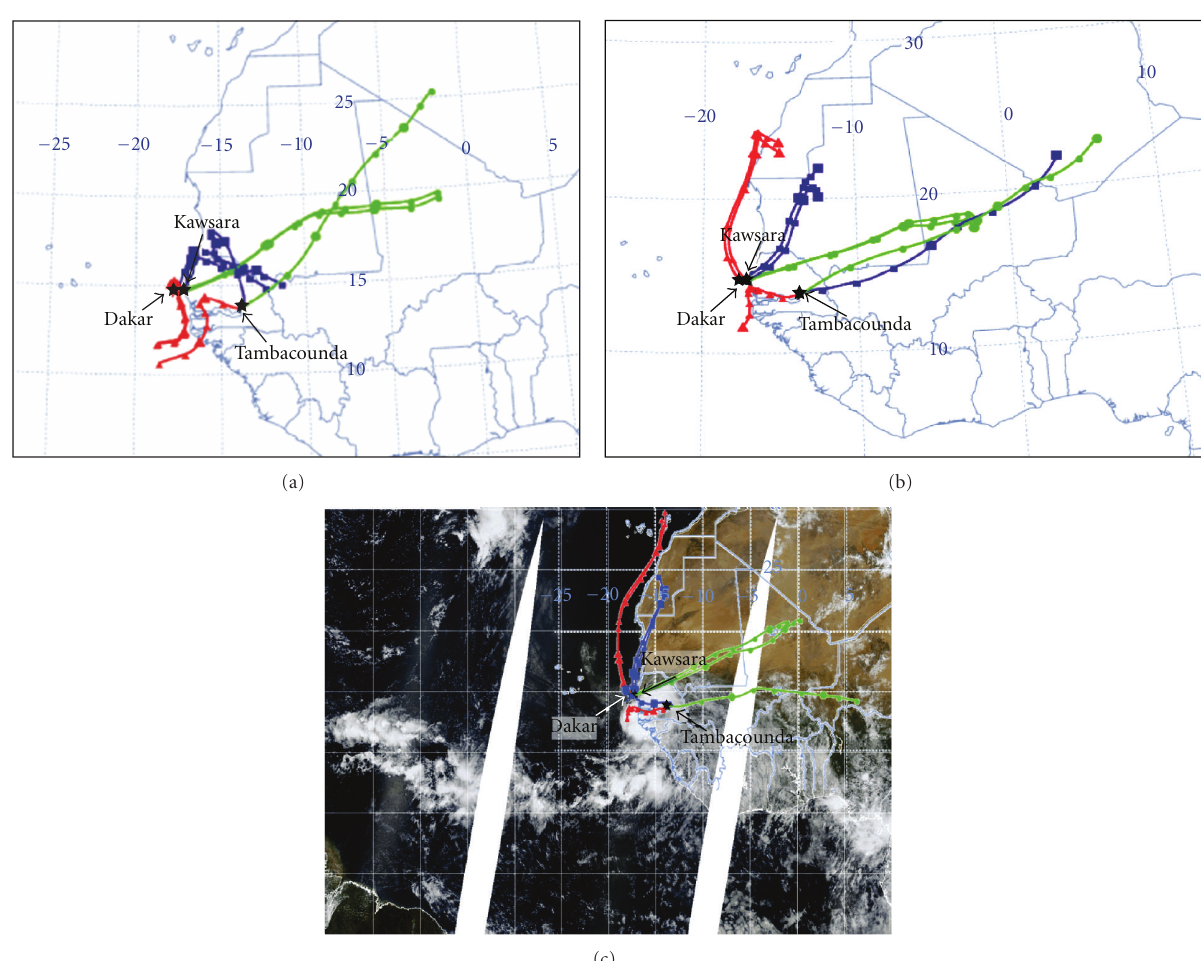
Figure 14: (a) The 48-hour HYSPLIT back-trajectory valid for 1200 UTC 10 September 2006. (b) The 48-hour HYSPLIT back-trajectory valid for 0000 UTC 11 September 2006. (c) The 1150 UTC Terra MODIS Visible Composite Satellite and 48-hour HYSPLIT back-trajectories valid 1200UTC, 11 September 2006. Back-trajectories are for air parcels at 0.5km AGL (red), 1.5 km AGL (blue), and 3.0 km AGL